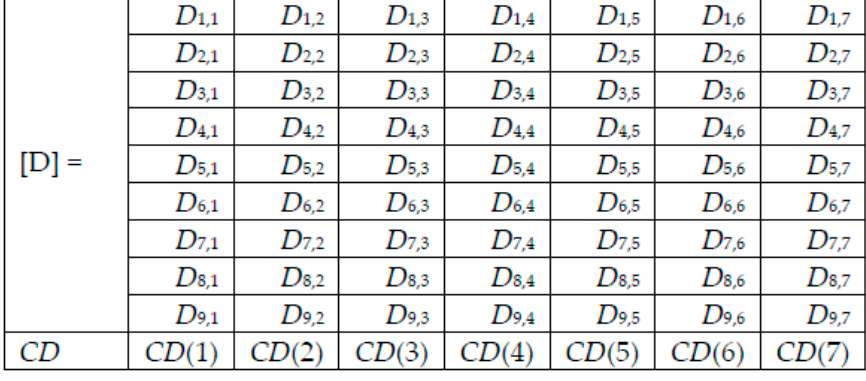
Figure 6. Decision matrix [ D ] and collective decision ( CD